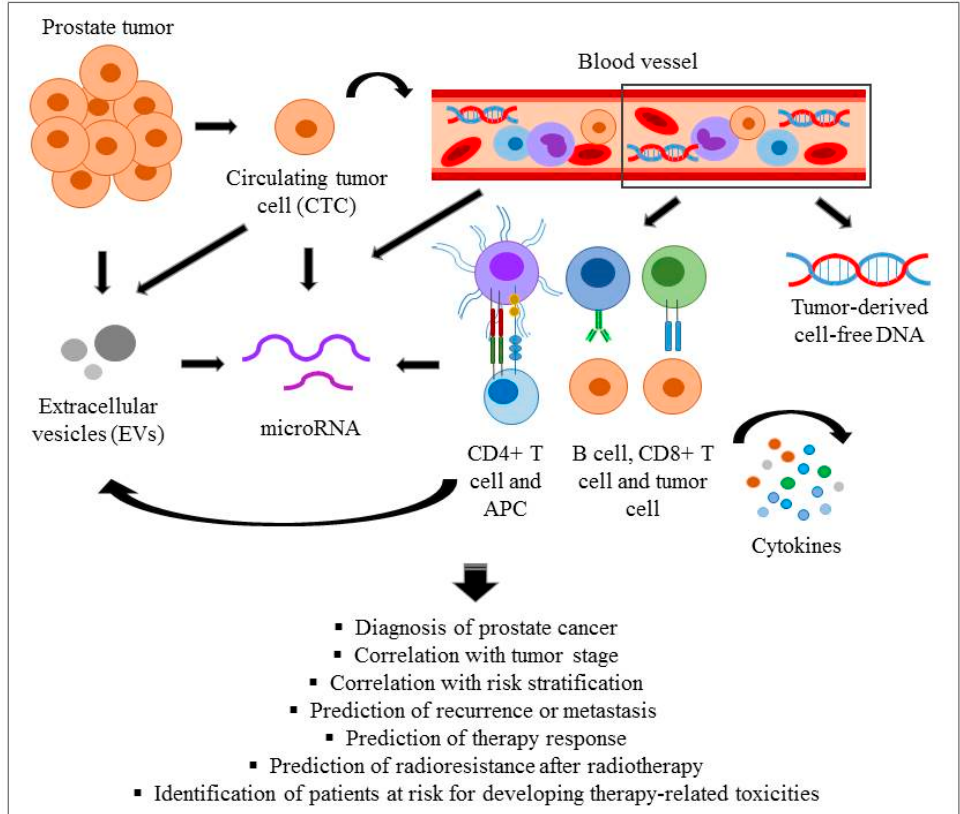
Figure 1. Overview of candidate blood-based liquid biopsy markers in prostate cancer patients.